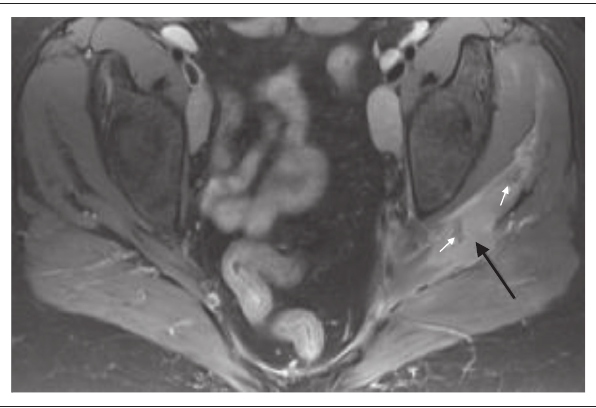
FIGURE 2: Axial proton density fat saturation (PDFS) image of the pelvis. Mass-like enlargement and hyperintensity of the gluteus medius muscle (long black arrow) with amorphous hypointense calcium deposits (short white arrows). Reactive external iliac adenopathy is also evident.